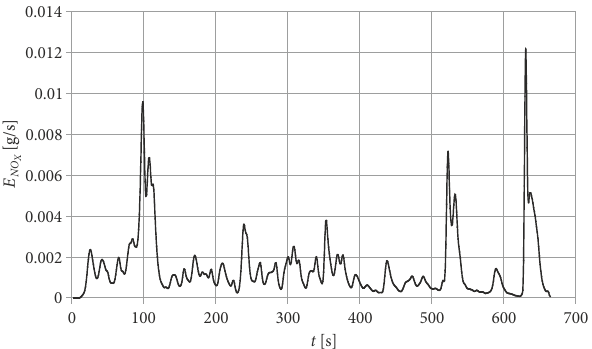
Figure 13. Time history of the nitrogen oxides emission intensity E NO in the CT1 test X